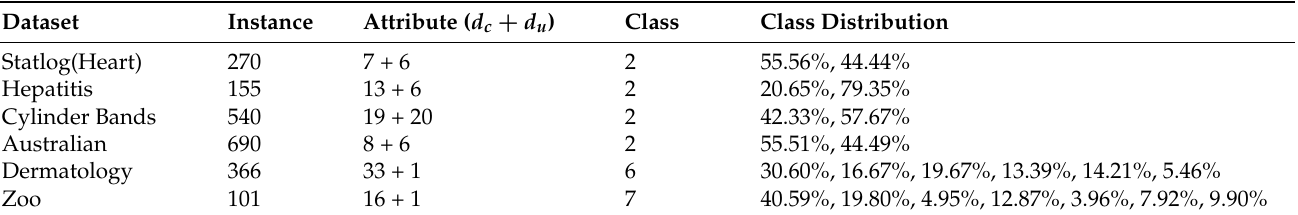
Table 1. Description of mixed datasets.